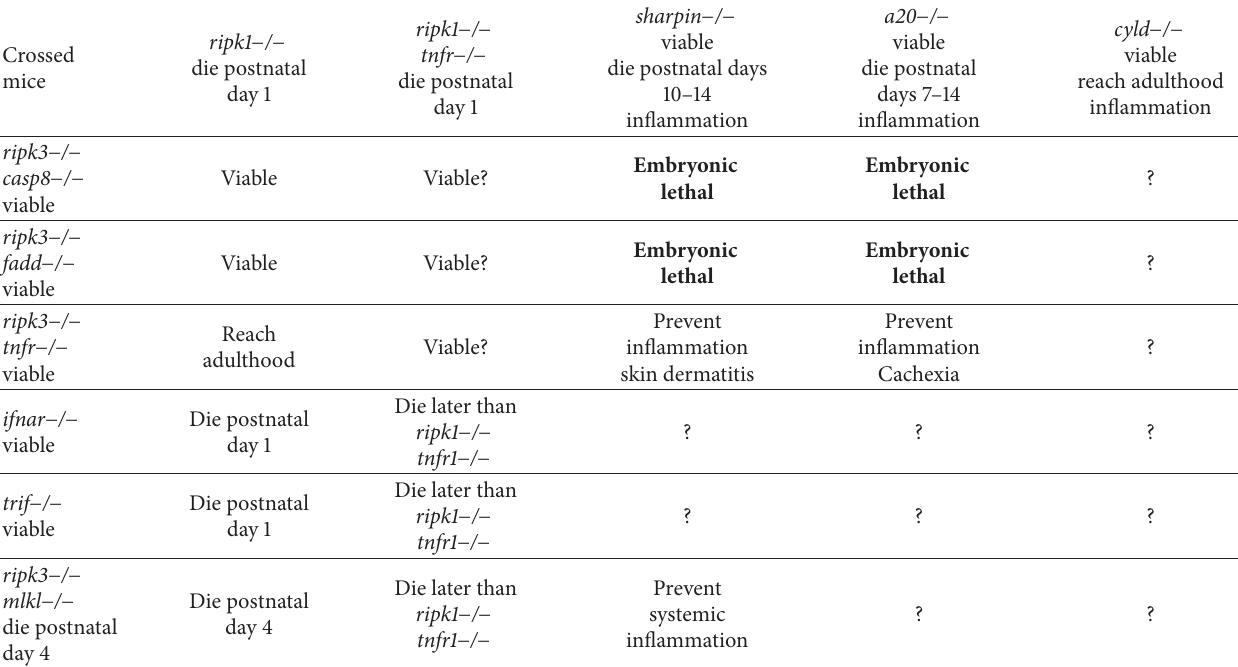
Table 2: Summary of phenotypes in double- and triple-knockout mice ablated for genes that regulate apoptosis, necroptosis, and